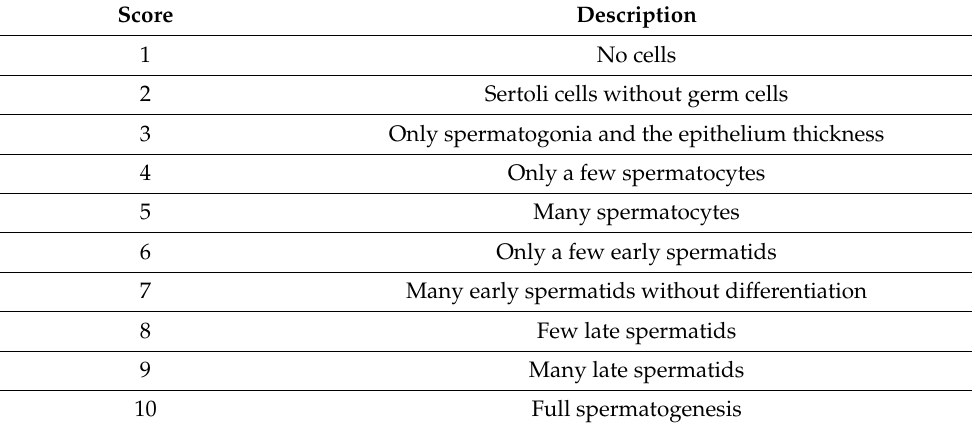
Table 1. Mean testicular biopsy score (MTBS)